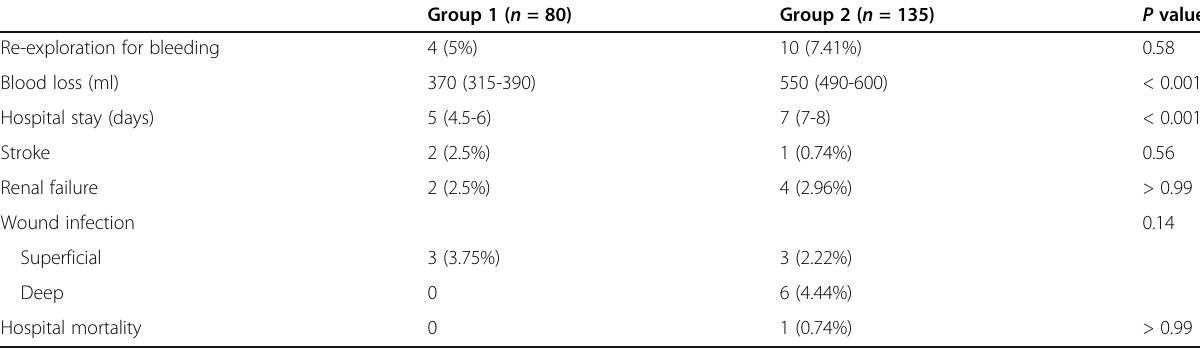
Table 3 Postoperative